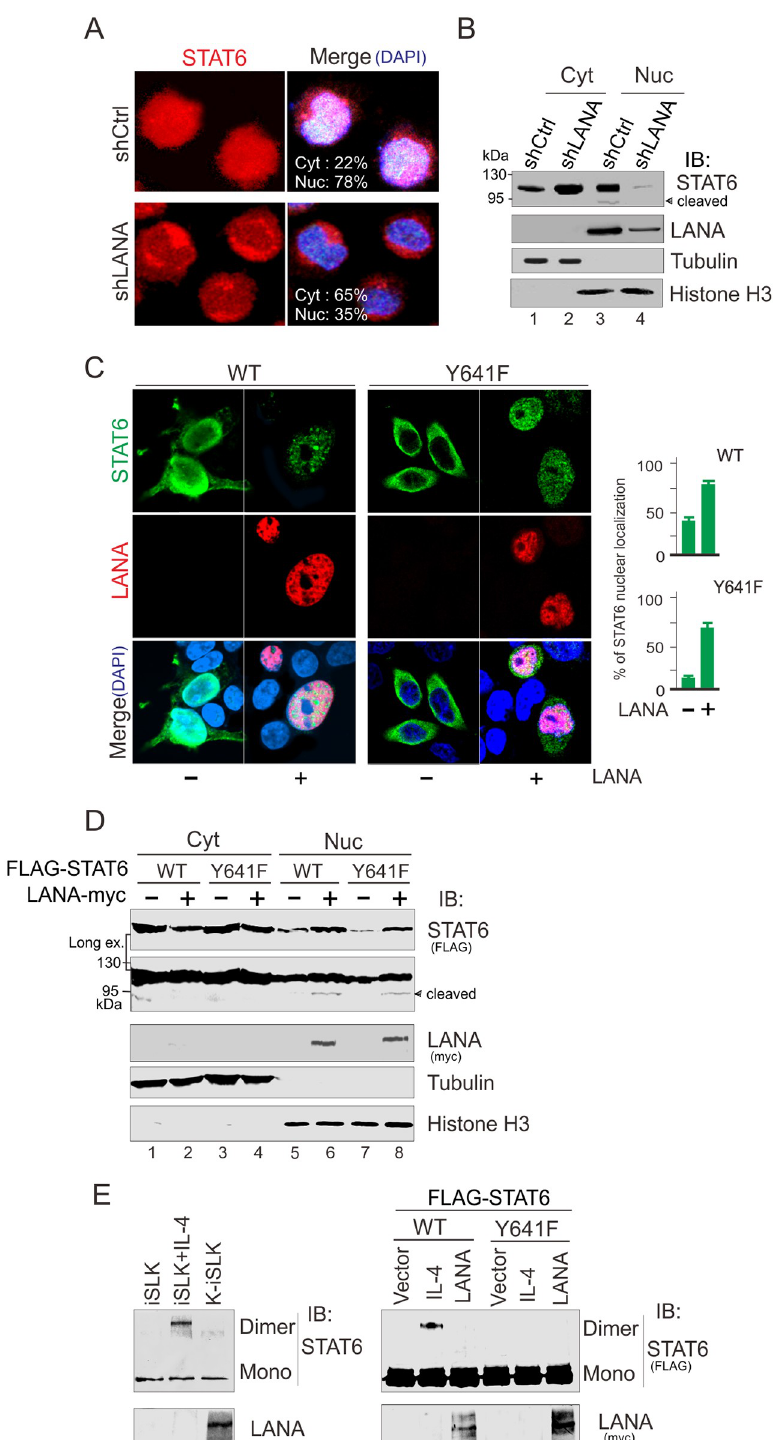
Fig 3. LANA promotes nuclear localization of STAT6 independent of Y641-phosphorylation. ( A ) Inhibition of LANA blocks nuclear localization of STAT6. Confocal microscopy of endogenous STAT6 (red) and merged in PEL cells BC3 with lentivirus-mediated constitutively knocked down of LANA (shLANA) or luciferase control (shCtrl). Nuclei were stained with DAPI. ( B ) Western blot analyses of fractionated BC3 cells with LANA or luciferase control knockdown. Cyt, cytosolic; Nuc, nuclear; were revealed by α -tubulin and Histone H3, respectively. ( C ) LANA induces nuclear localization of exogenous STAT6 independent of phosphorylation on tyrosine 641. HEK293 cells transfected with wild type (WT) or Y641 mutant (Y641F) of STAT6 with FLAG tag (green) in the presence or absence of LANA